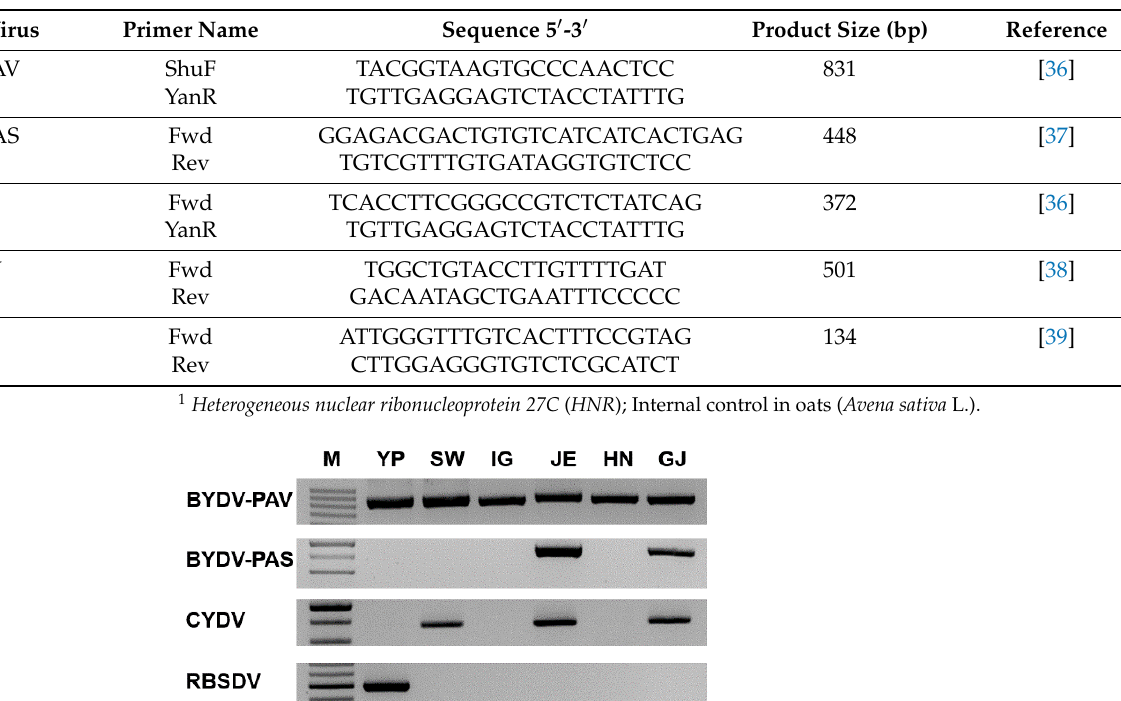
Table 4. Information of primers used for RT-PCR.